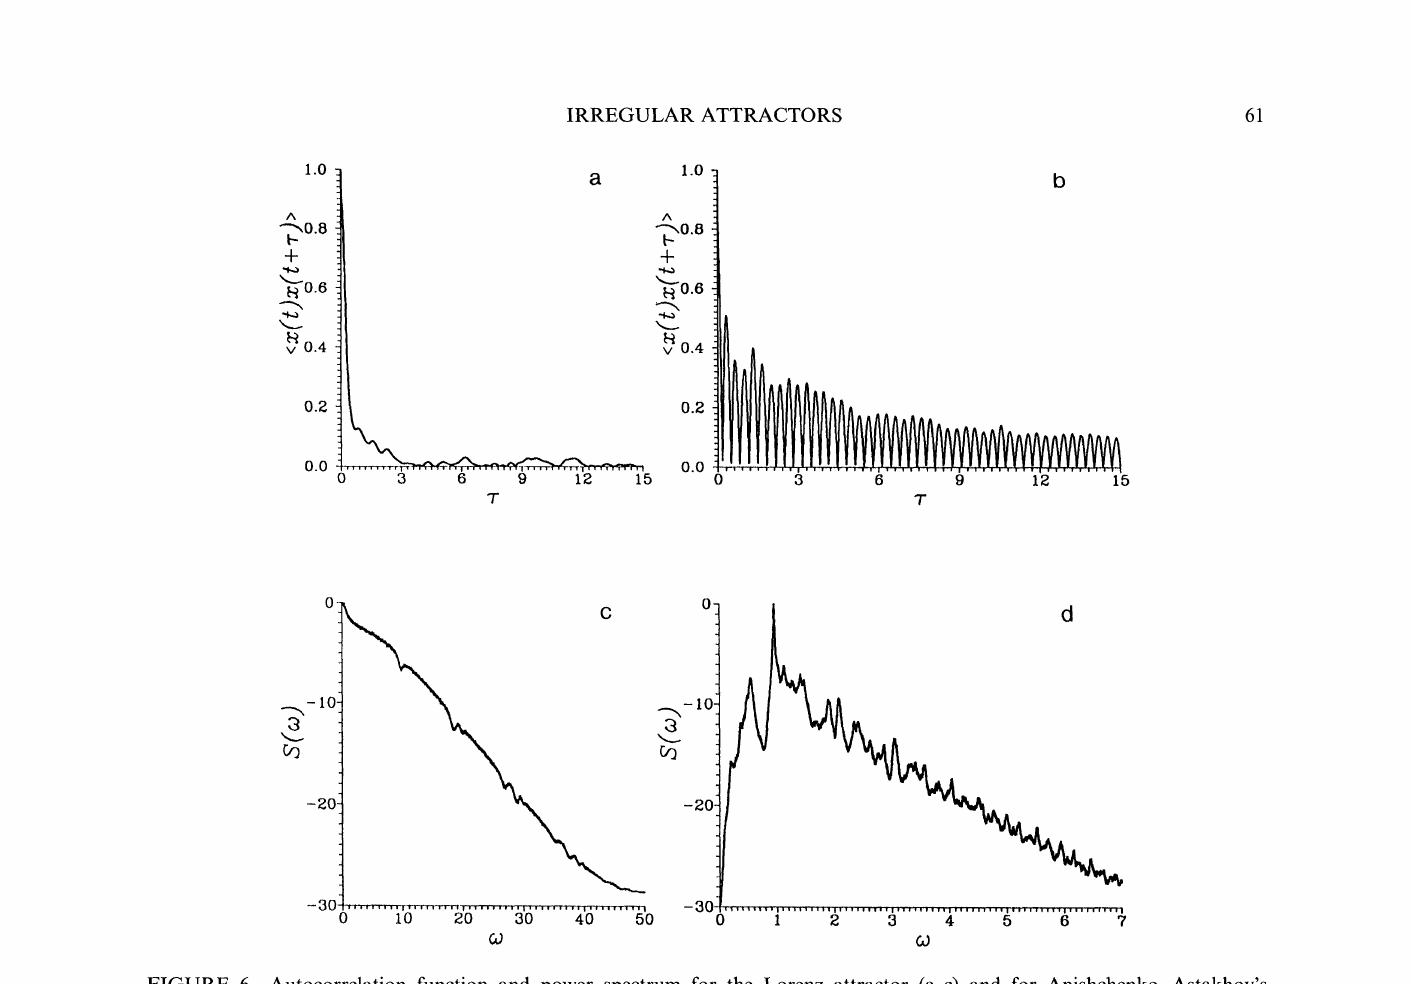
FIGURE 6 Autocorrelation function and power spectrum for the Lorenz attractor (a, c) and for Anishchenko-Astakhov’s oscillator (b, d). trajectories in the bounded region Go of phase space, which all or almost all the trajectories from the region G1 including Go approach, is called the quasiattractor of the dynamical